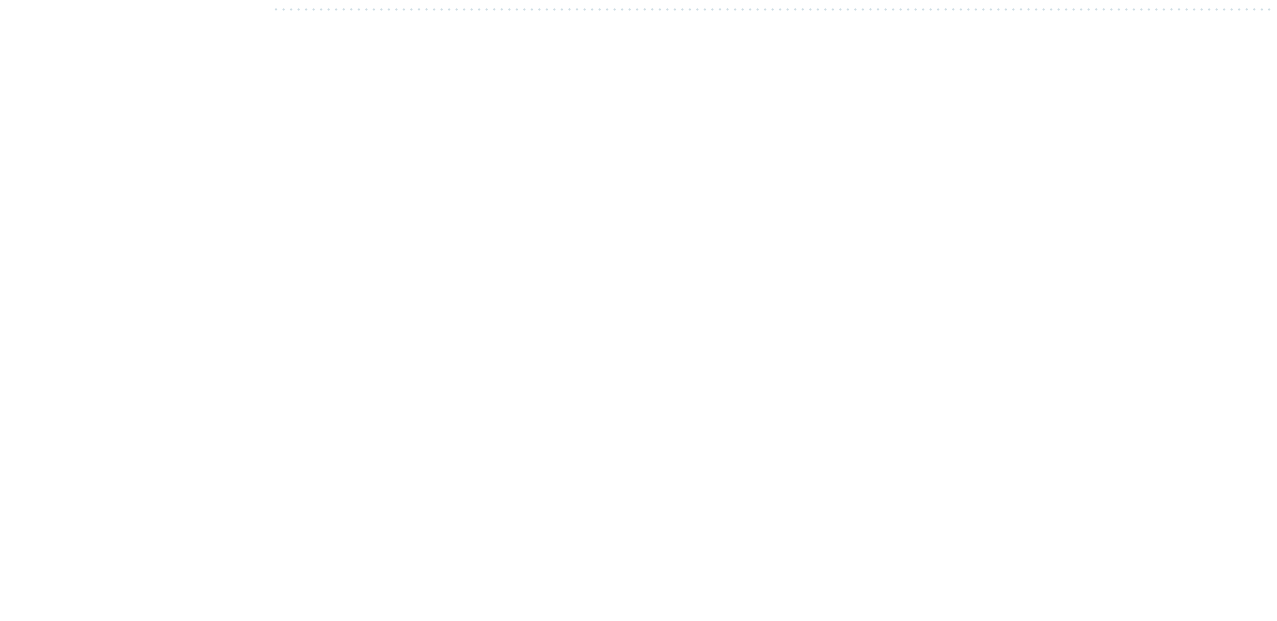
Figure 4. Cross plots for GPR model containing kernel function of ( a ) Exponential, (b ) Matern, ( c ) Squared exponential and ( d ) Rational